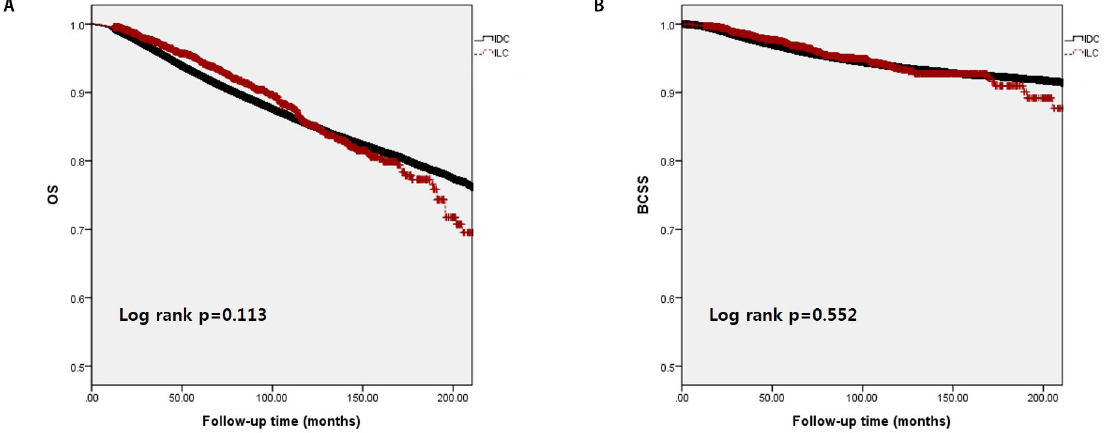
Fig 1. Kaplan–Meier survival analysis of overall survival (OS) (A) and breast cancer-specific survival (BCSS) (B) between the invasive ductal carcinoma and invasive lobular carcinoma